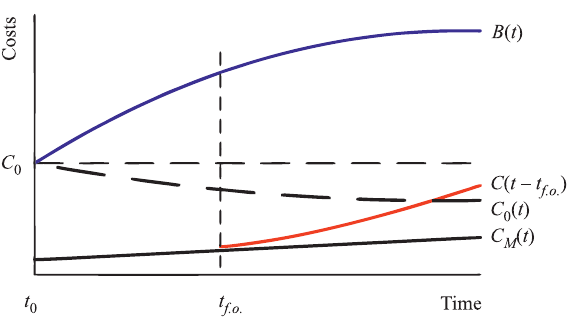
Fig. 2. Benefits and life cycle costs associated with a bridge in service